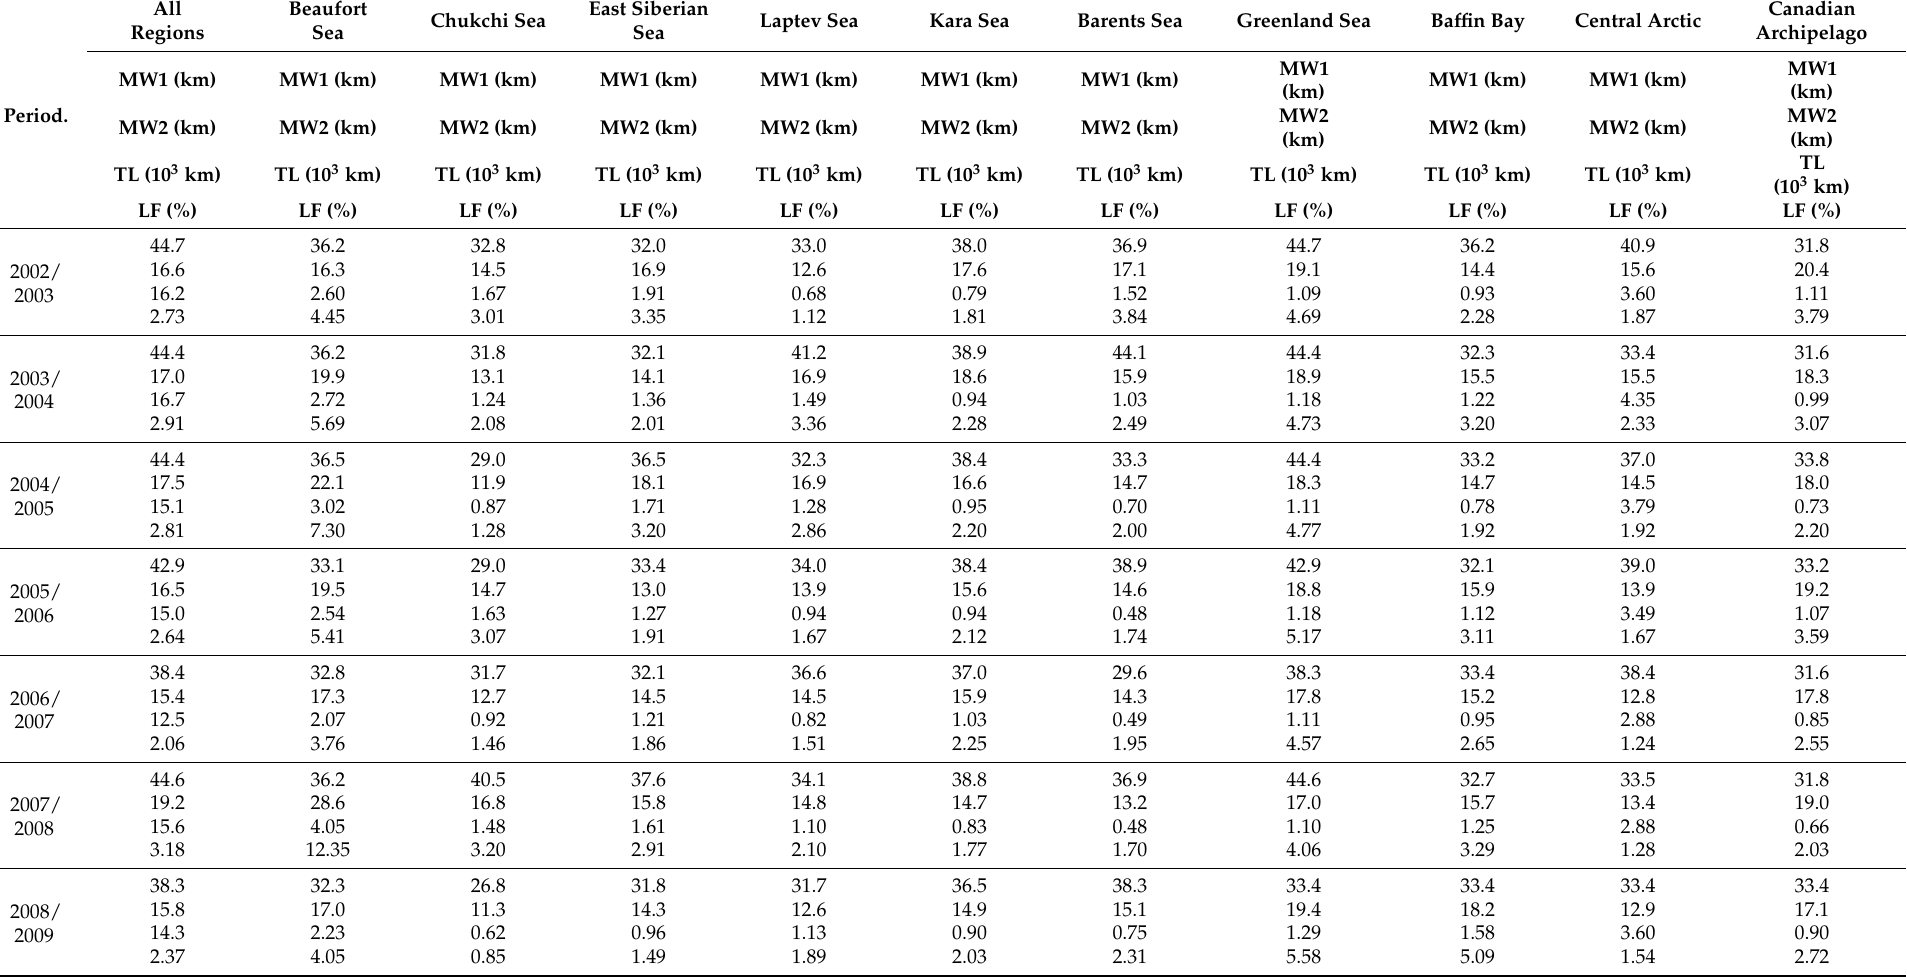
Table 1. Statistics of lead geometry in the AMSR family data from 2002/2003 to 2019/2020, except 2011/2012. Here, MW1, MW2, and TL represent the max width, mean width, and total length of detected leads,